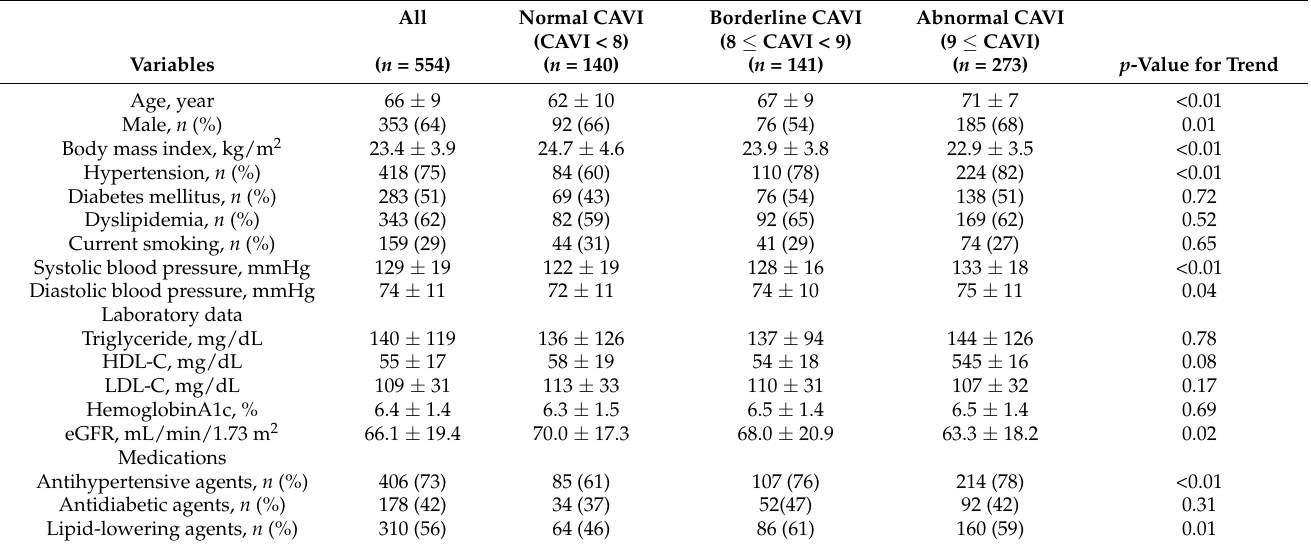
Table 1. Baseline Characteristics According to the CAVI.